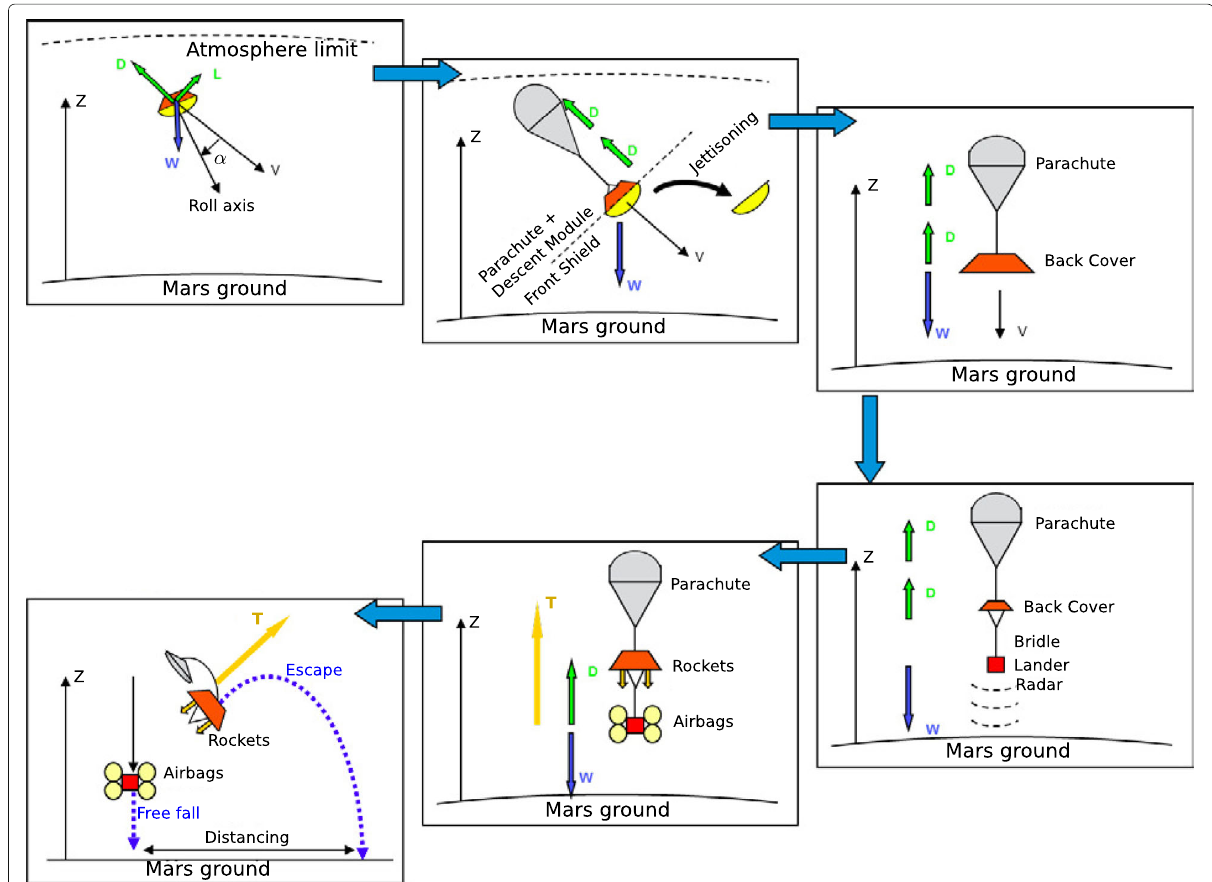
Fig. 7 Entry, descent and landing system